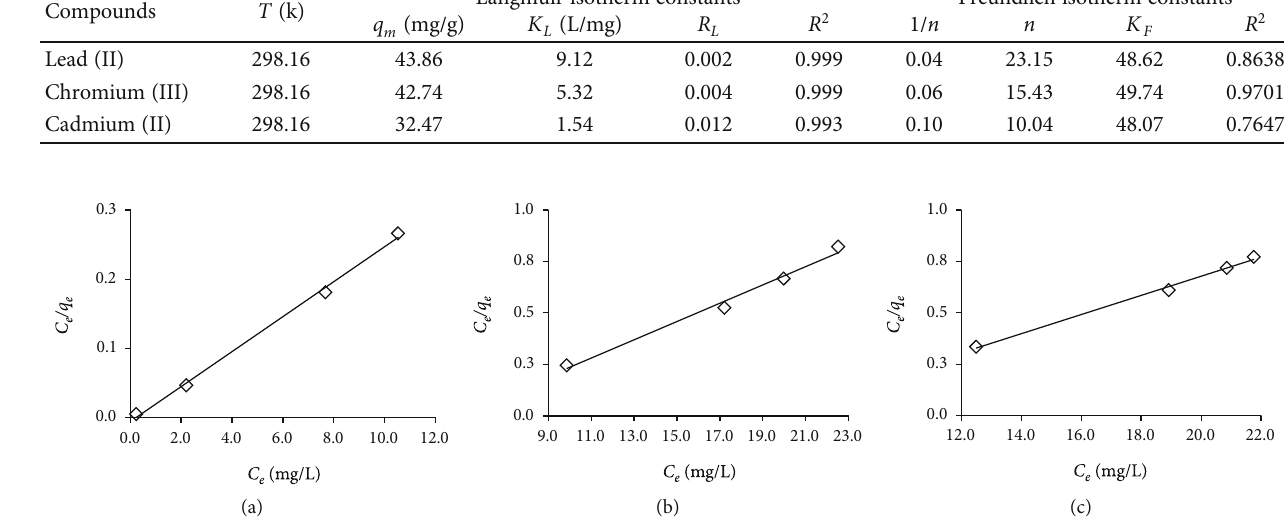
Figure 17: Langmuir adsorption isotherms for adsorption of (a) Pb (II), (b) Cr (III), and (c) Cd (II) on amidoxime chelating resin, pH 5, and temperature at 25 °